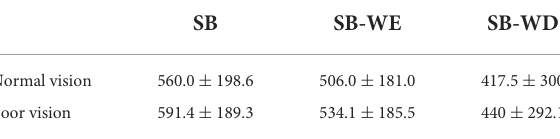
TABLE 13 Differences in sedentary time of children and adolescents with different vision conditions (min/d).